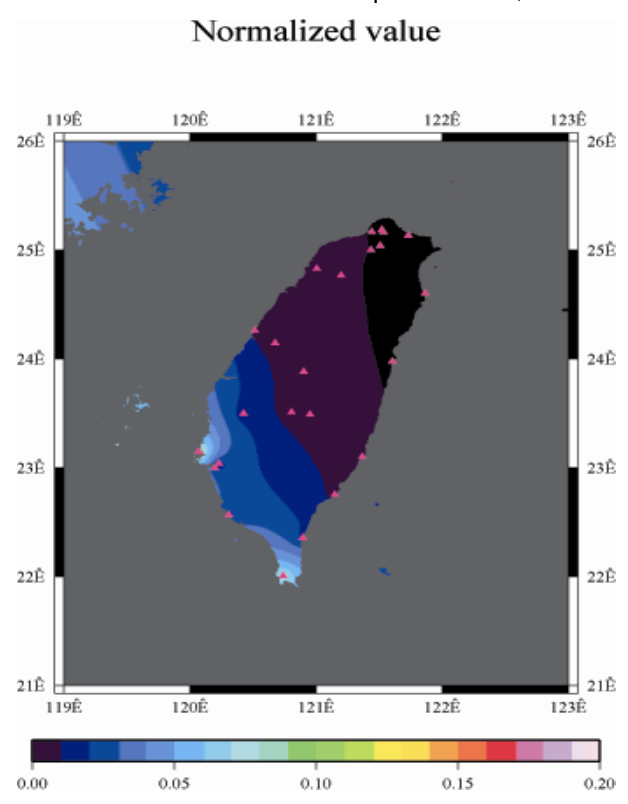
Figure 21. Normalized values of rainfall before plum rains (June 2nd, 2008, 5:00